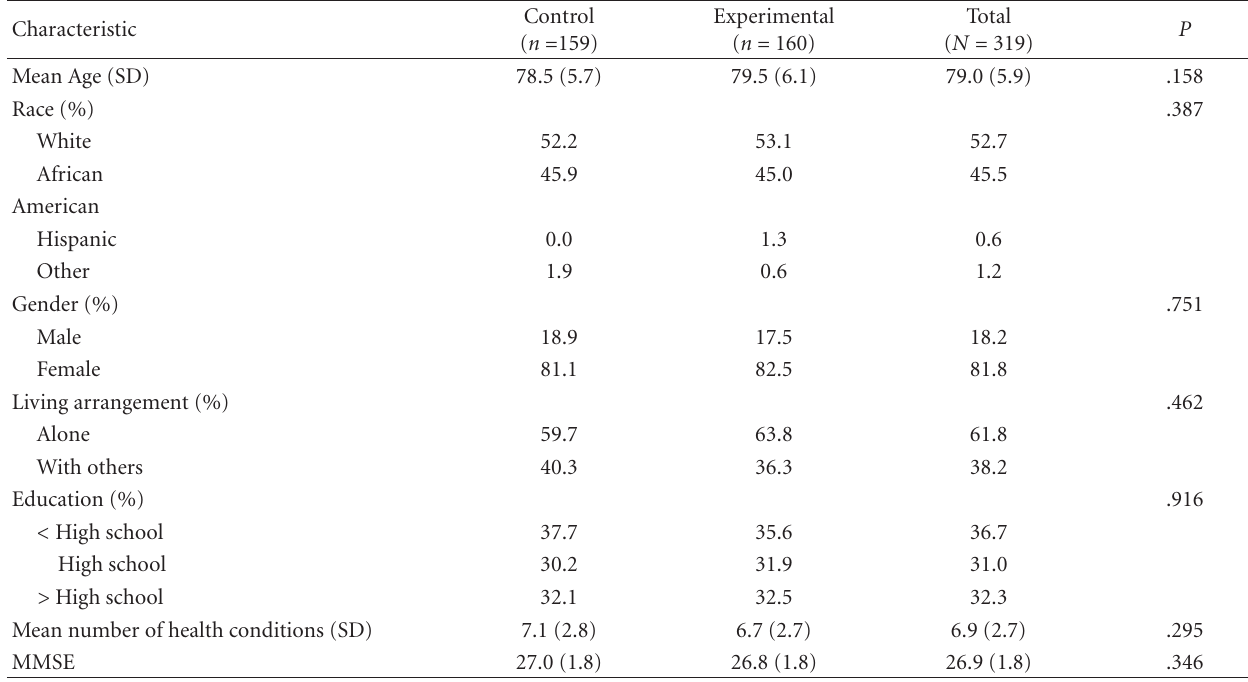
Table 1: Background